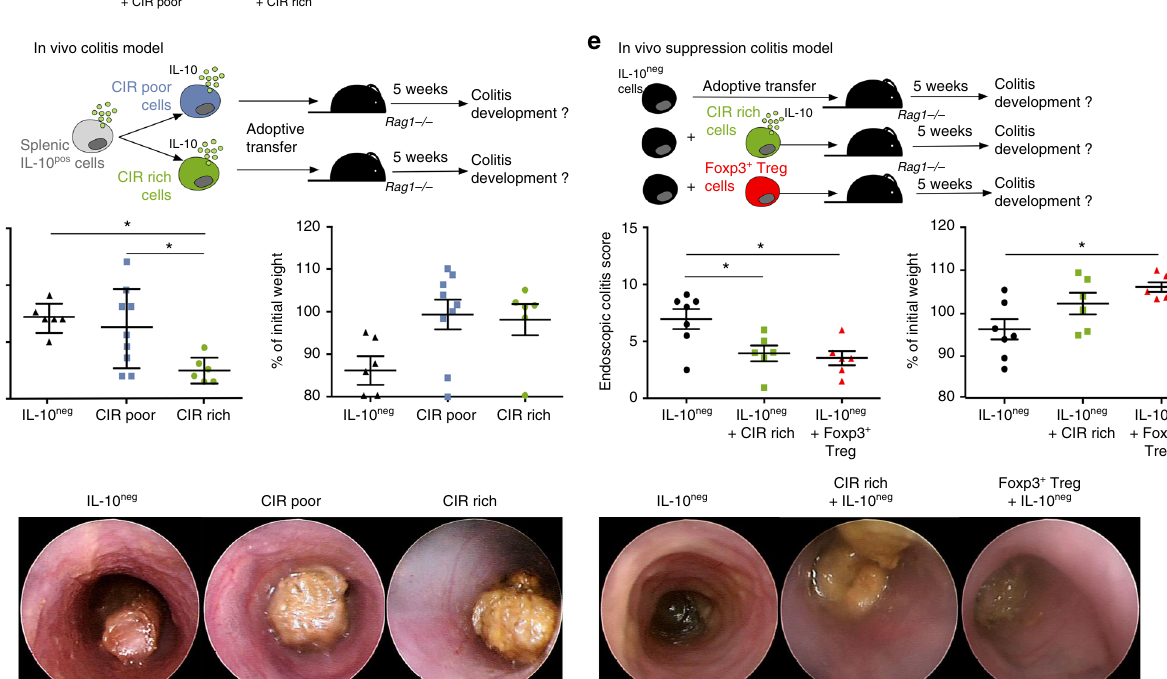
Fig. 4 CIR rich CD4 + T cells have a high suppressive capacity. a In vitro suppression of co-inhibitory receptor rich (CIR rich) and co-inhibitory receptor poor (CIR poor) IL-10 pos Foxp3 neg CD4 + T cells isolated from spleen of aCD3-treated IL-10 eGFP Foxp3 mRFP double reporter mice. Representative histograms of fi ve independent experiments, a paired T- test was used to calculate signi fi cance. b In vitro suppression of CIR rich and CIR poor IL-10 pos Foxp3 neg CD4 + T cells isolated from spleen of P. berghei infected IL-10 eGFP Foxp3 mRFP double reporter mice. Representative histograms of four independent experiments. c In vitro suppression of CIR rich and CIR poor IL-10 pos Foxp3 neg CD4 + T cells isolated from spleen of aCD3-treated IL-10 eGFP Foxp3 mRFP reporter mice. TIM-3 and LAG-3 were blocked using blocking antibodies. To block IL-10 receptor signaling responder T cells were isolated from IL-10R dominant negative mice (DN IL-10R Responder). Results are cumulative of three independent experiments. d CIR rich and CIR poor IL-10 pos Foxp3 neg CD4 + T cells and IL-10 neg CD4 + T cells were isolated from spleen of aCD3-treated IL-10 eGFP Foxp3 mRFP double reporter mice. Cells were transferred into lymphopenic hosts and colitis development was assessed by weight loss and endoscopic colitis score 5 weeks upon transfer (IL-10 neg n = 6; CIR poor n = 9; CIR rich n = 6; lines indicate mean±SEM). Results are cumulative of three independent experiments. One-way ANOVA (post-test Tukey) was used to calculate signi fi cance (* p < 0.05). e CIR rich IL-10-producing Foxp3 neg CD4 + T cells, IL-10 neg CD4 + T cells and Foxp3 + Treg cells were isolated from spleen of aCD3-treated IL-10 eGFP Foxp3 mRFP double reporter mice. IL-10 pos CIR rich or Foxp3 + Treg cells were co-transferred with IL-10 neg CD4 + T cells and colitis development was assessed by weight loss and endoscopic colitis score 5 weeks upon transfer (IL-10 neg n = 7; IL-10 neg + CIR rich n = 6; IL-10 neg + Foxp3 + Treg n = 6; lines indicate mean±SEM). Results are cumulative of three independent experiments. One-way ANOVA (post-test Tukey) was used to calculate signi fi cance (* p <